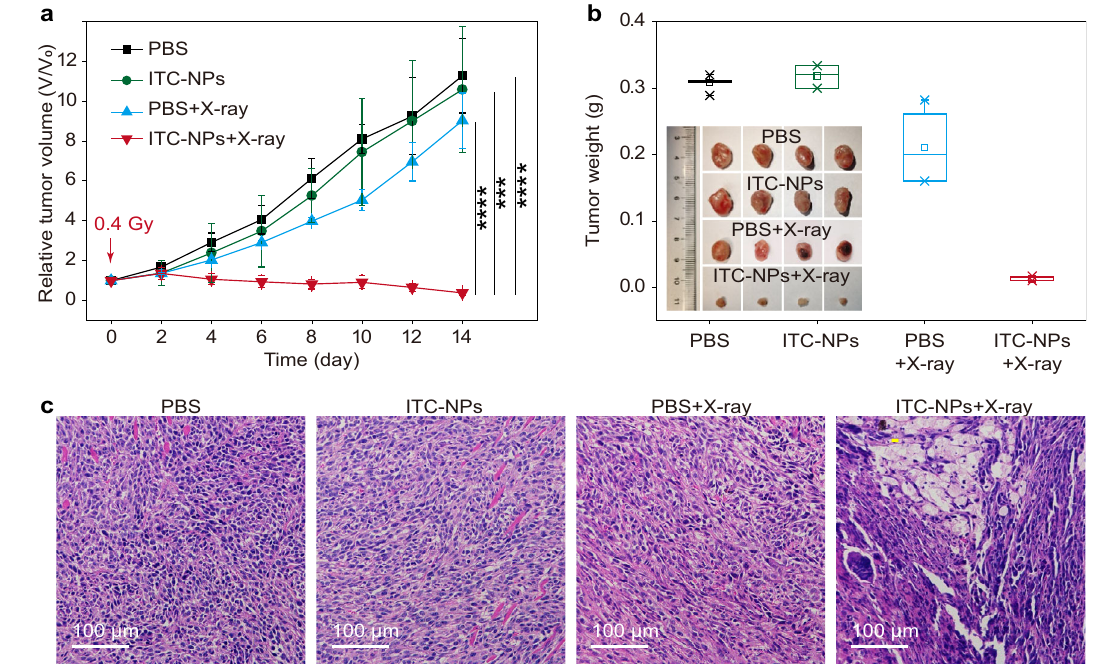
Fig. 4 | Assessment of organic phosphorescent nanoscintillator for X-PDT in vivoafterintravenousinjection.a Tumourgrowthcurvesof4T1tumours with different treatments (**** P <0.0001, *** P =0.0003). On day 0, 0.4Gy X-ray irra- diation was given without further treatment. The statistical data are expressed as mean values±S.D. ( n =5 biologically independent animals). Statistical signi fi cance